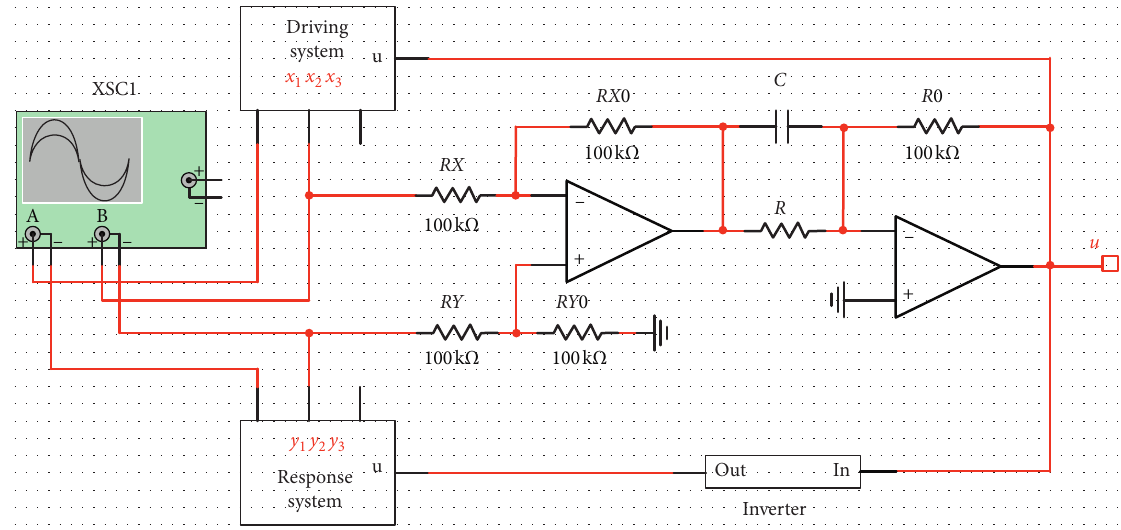
Figure 7: Schematic diagram of the electronic circuit realization of the coupled system.